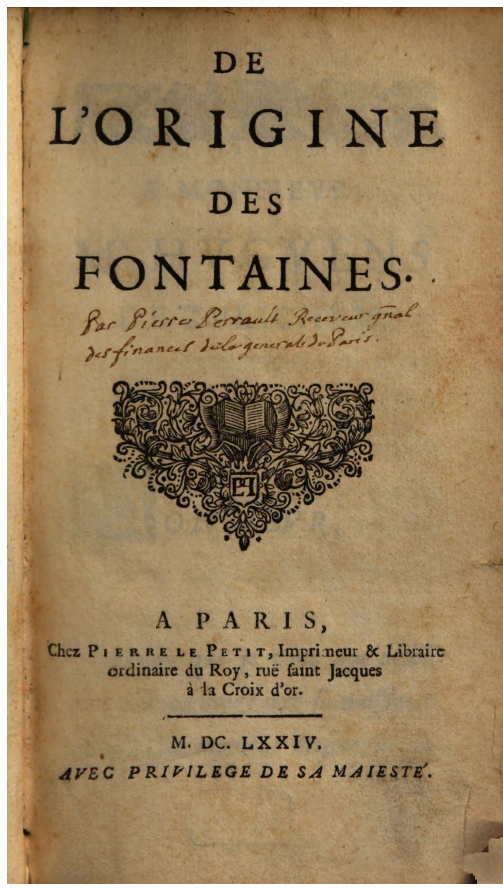
Figure 1. Front matter of Perrault’s opus De l’origine des fontaines (Perrault, 1674, credits: Bayerische Staatsbibliothek München, Rar. 4600, sheet 7, urn:nbn:de:bvb:12-bsb10862482-0).